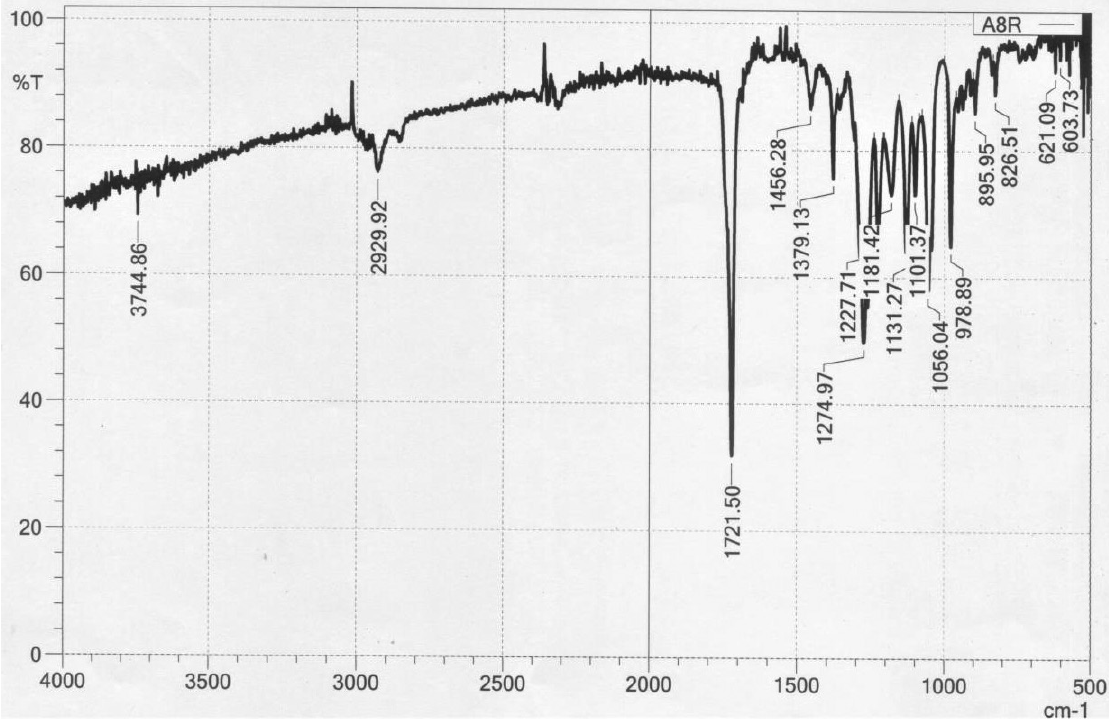
Figure 6: FTIR spectrum of PHA produced by strain PWF ( Bacillus tequilensis ; MH142145) showing absorption band at 1721.50 cm −1 which is a reported PHA marker band (C=O